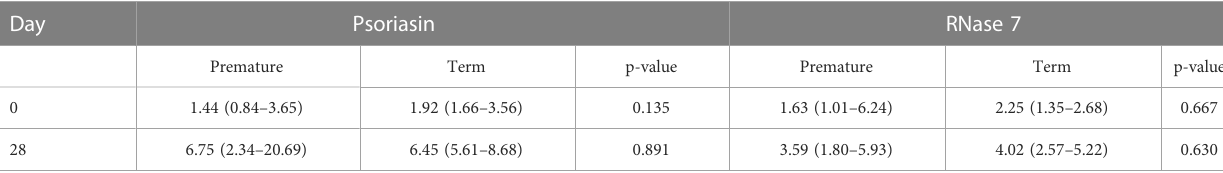
TABLE 4 Median (IQR) concentrations of psoriasin and RNase 7 in premature and term infants after exclusion of infants with chorioamnionitis and/or sepsis. P-values derived from Mann – Whitney U-test. No signi fi cant fi ndings (p <